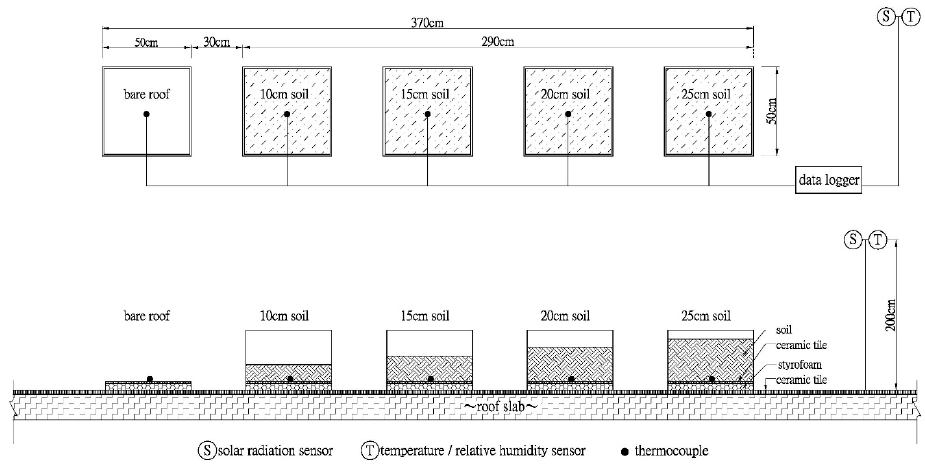
Figure 4. Experimental setup for the first stage. The plan ( top ) and the elevation ( bottom ).